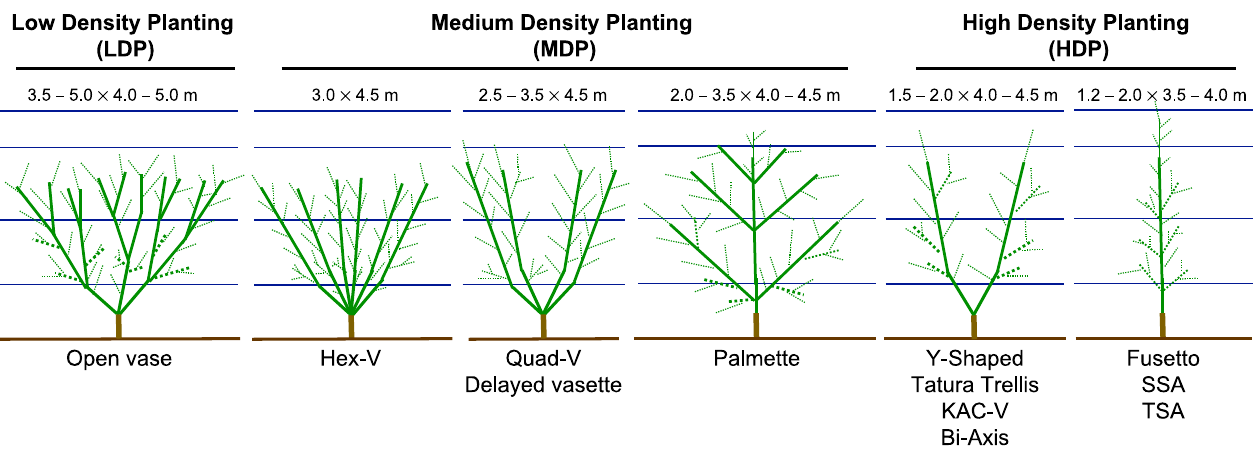
Figure 4. Canopy architectures of the most widely used training systems in peach and their planting densities. Spacings listed as: intra-row × inter-row.